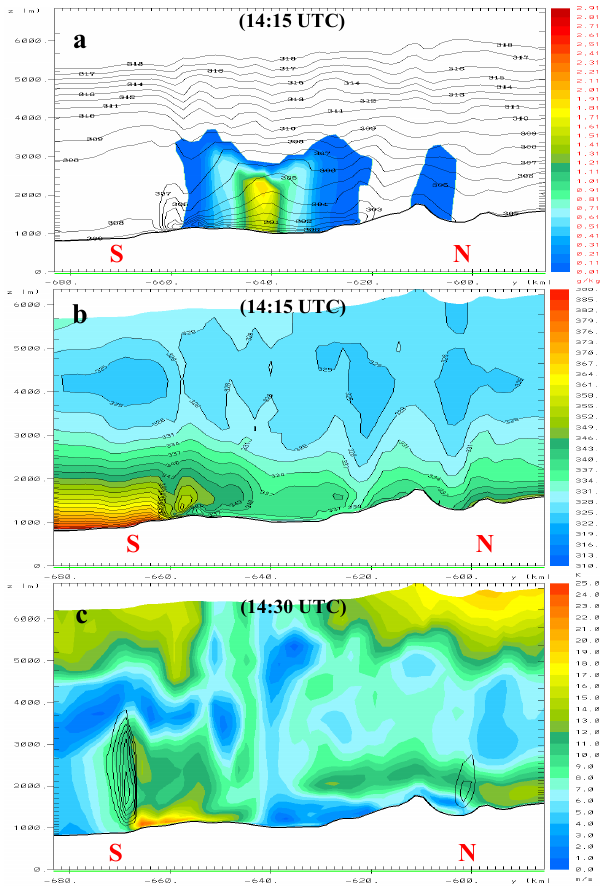
Fig. 5. North to south vertical cross-sections of: (a) Rain mixing ratio (colour palette in gkg − 1 ) and potential temperature (contour lines in K) at 14:15UTC. (b) Equivalent potential temperature ( θ e ) in K. (c) Horizontal wind speed (colour palette in ms − 1 ) and ver- tical updrafts (black line contours every 0.5ms − 1 ) at 14:30UTC. The cross section is at x = −